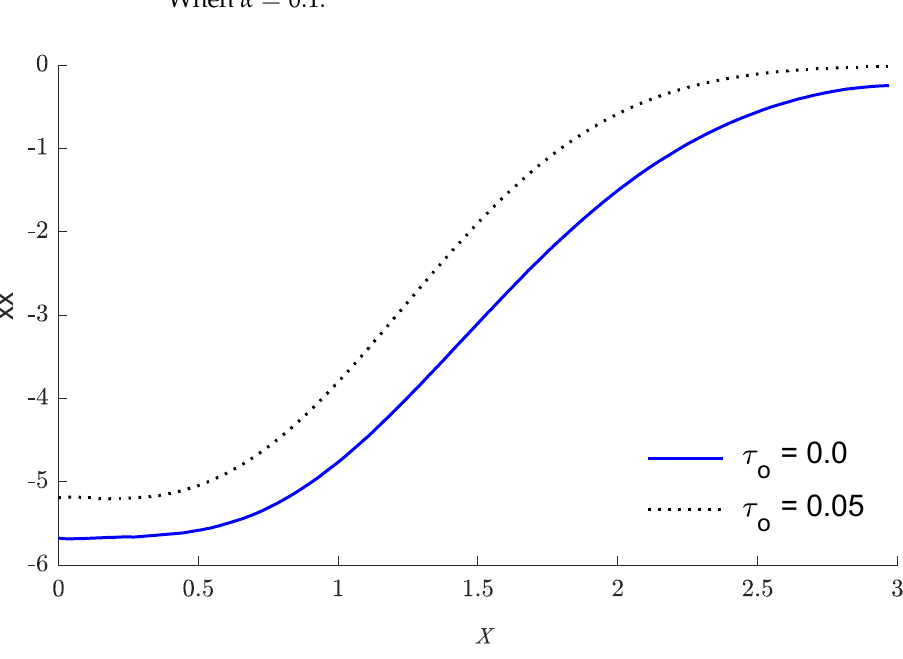
Figure 10. The stress distribution via the distance 𝑥 with and without thermal relaxation time. When 𝛼 = 0.1